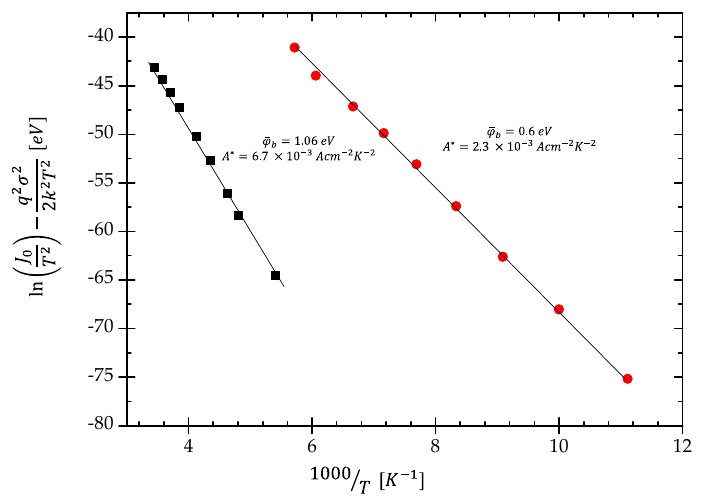
Figure 7. The modified Richardson’s plot.